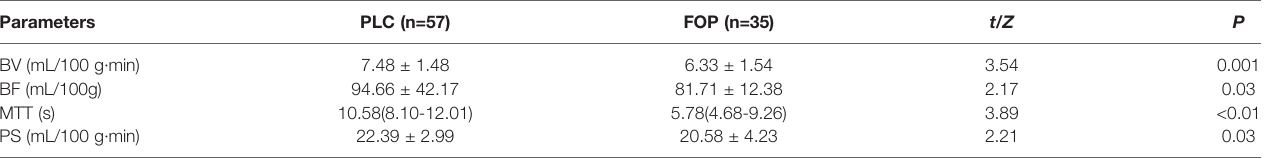
TABLE 3 | Comparison of perfusion parameters of PCL and FOP.